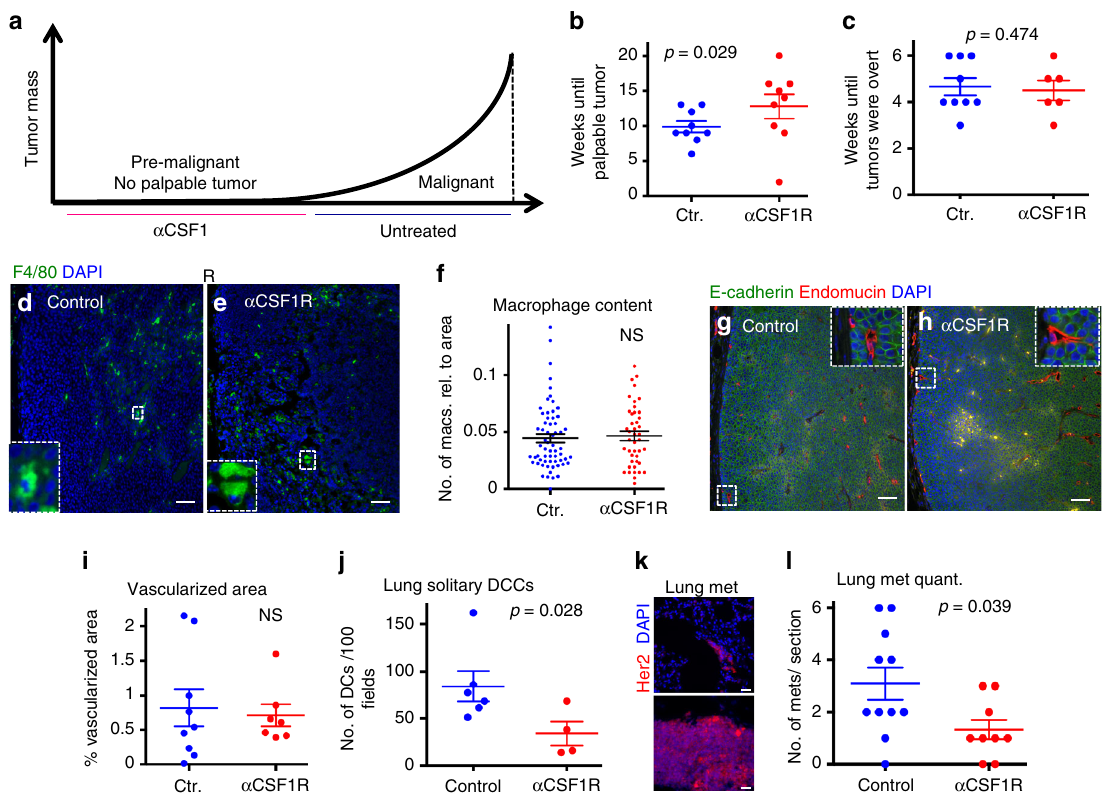
Fig. 4 Early disseminated cancer cells contribute to metastasis formation. Macrophages were depleted from pre-malignant MMTV-HER2 mice by ASF98 treatment starting at week 18. Treatment was stopped when mice developed palpable tumors (1 – 3 mm average). a Mice were left until tumors reached 1 cm in diameter and then sacri fi ced. b Time from beginning of treatment at age wk18 until development of palpable tumors as mean ± SEM (9 mice each, 23 – 38 wks old). c Time from formation of palpable tumors until tumors were overt (26-43 wks old) as mean ± SEM (control N = 9, anti-CSF1R N = 6). Macrophages in sections of overt tumors (at least three animals per group) were identi fi ed by staining against F4/80 at the end of the experiment ( d , e ; bar: 100 μ m; zoom factor in insets 5x) and quanti fi ed as the number of macrophages relative to tumor area ( f ; statistical analysis: Mann – Whitney test). Vascularization of overt tumors was analyzed by staining against endomucin, an endothelial cell marker ( g , h ; bar: 100 μ m; zoom factor in insets 4x) and quanti fi ed as endomucin + area/tumor in at least three animals combined ( i ; mean ± SEM; statistical analysis: Mann – Whitney test). Solitary DCCs in lung sections and metastases de fi ned as cell clusters bigger than three cells were quanti fi ed in lung sections stained against HER2 ( j – l , bar: 25 μ m). For solitary cell analysis, the average of DCCs or metastases per 100 fi elds was counted; each dot represents one lung section. For metastasis analysis, the total number of metastases per lung sections was quanti fi ed and plotted ( j ). Number of mice N = 6 (control) and N = 4 ( α CSF1R) animals combined;